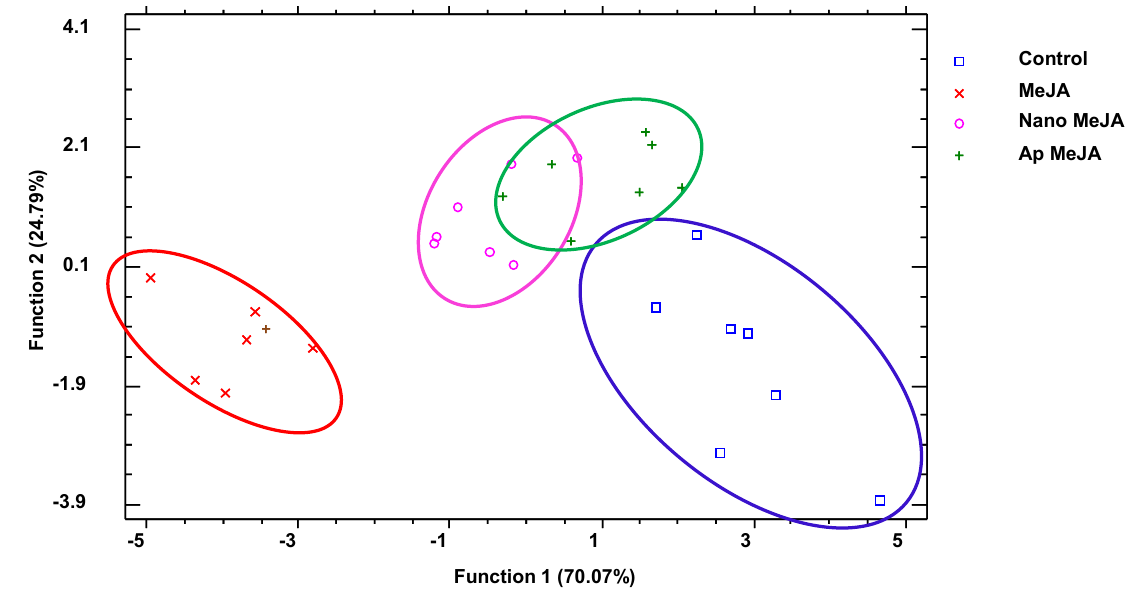
Figure 6. Representation of the first two discriminant functions separating the samples according to the treatments applied in vineyards.